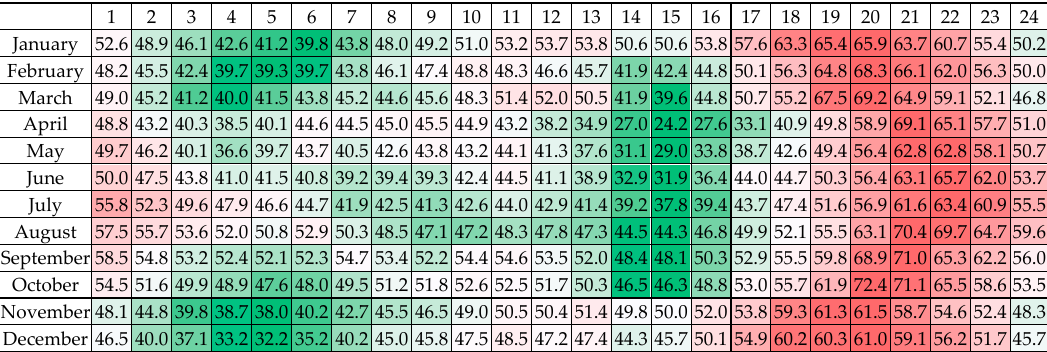
Figure 15. Average PUN Index trend over the reference months: non-working days. (Green: low; White: medium; Red: high).